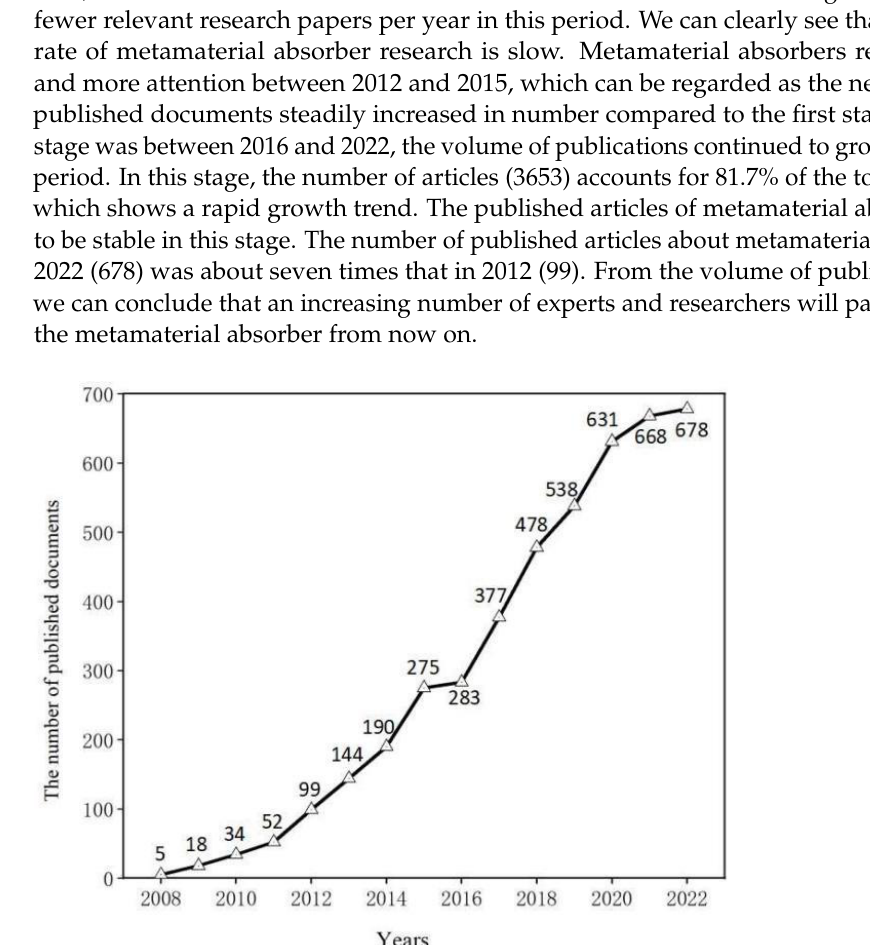
Figure 2. This graph can help us understand the distribution of research power in this field. A node represents a country/region. There are 79 nodes and 416 lines in the cooperation network of countries. The larger (fewer) connections indicate the larger (fewer) cooperation between countries in the field of metamaterial absorbers. We can see the font of China is the largest of all the countries. It shows that China has ranked first and has published the largest number of